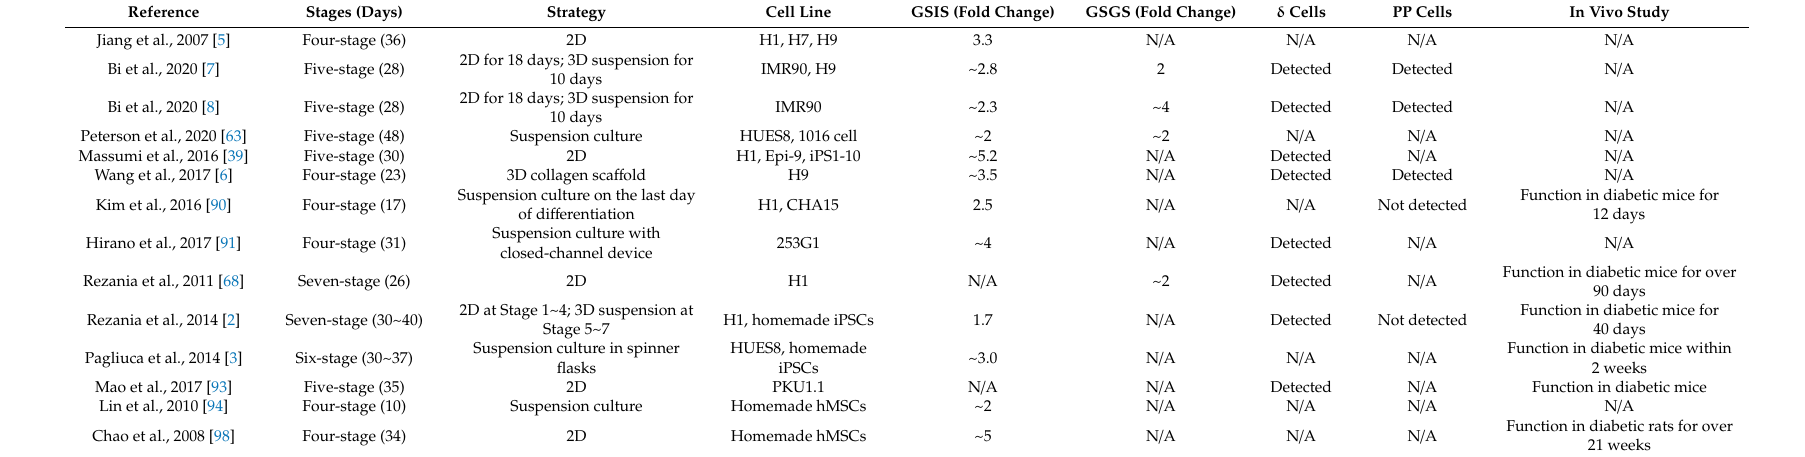
Table 3. Generation of pancreatic endocrine cells from pluripotent stem